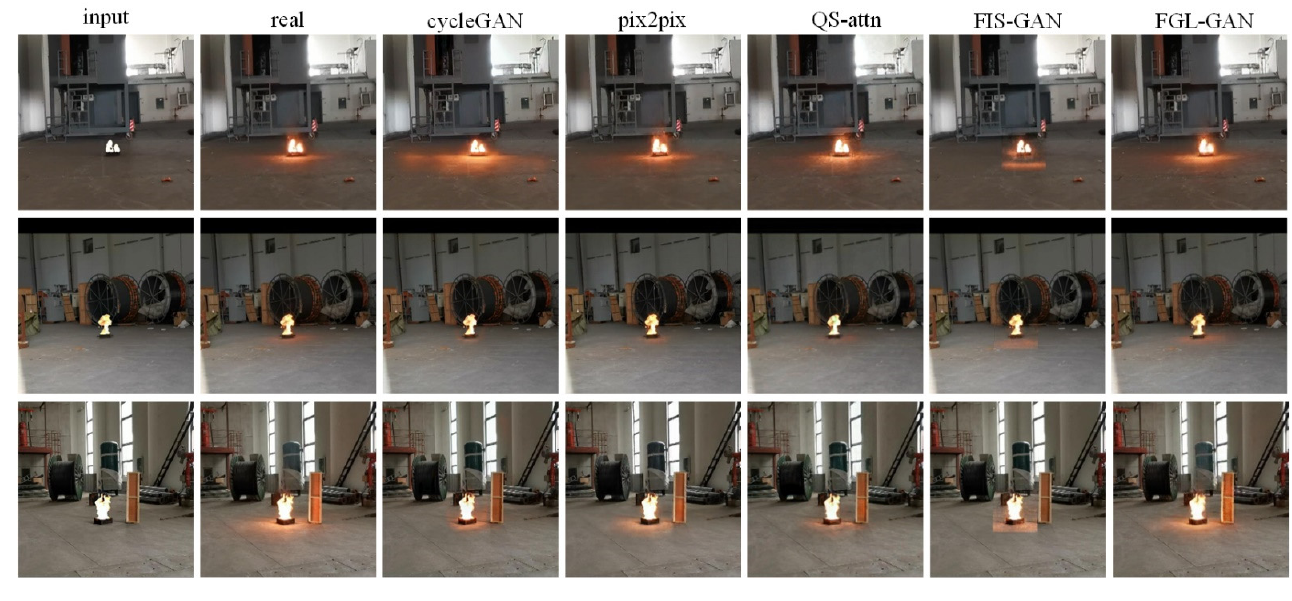
Figure 8. The example of the test sets.